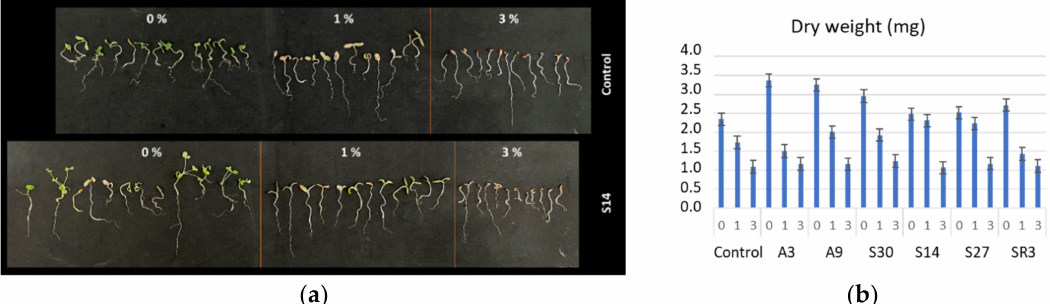
Figure 1. Plant growth promotion effects under salt stress of strains isolated from desert samples. ( a ) Comparison of the development of plants at 0, 1, and 3% of NaCl ( w / v ) in control vs. S14- inoculated plants; ( b ) differences observed in dry weight for all the samples tested under several saline